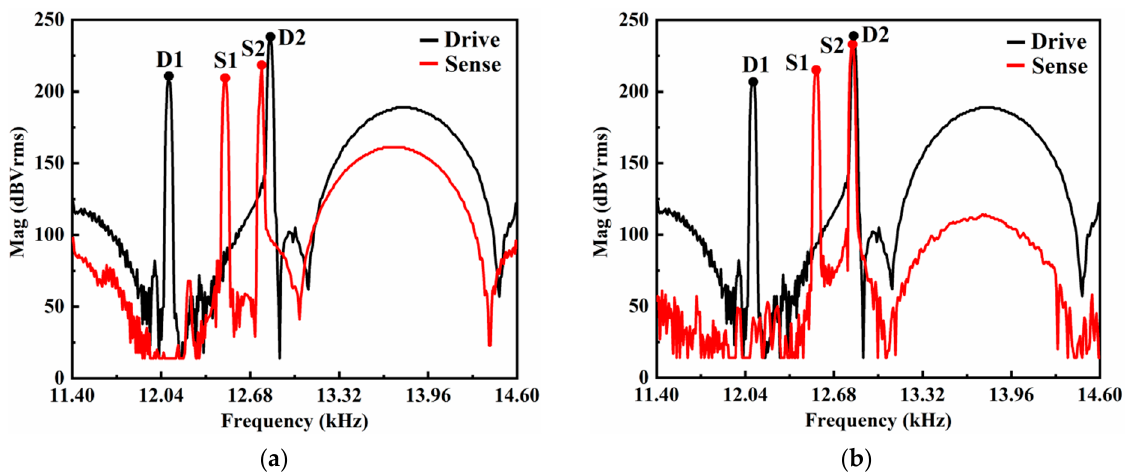
Figure 7. Comparisons of resonance frequencies ( a ) before and ( b ) after automatic mode-matching of dual-mass TFGs.